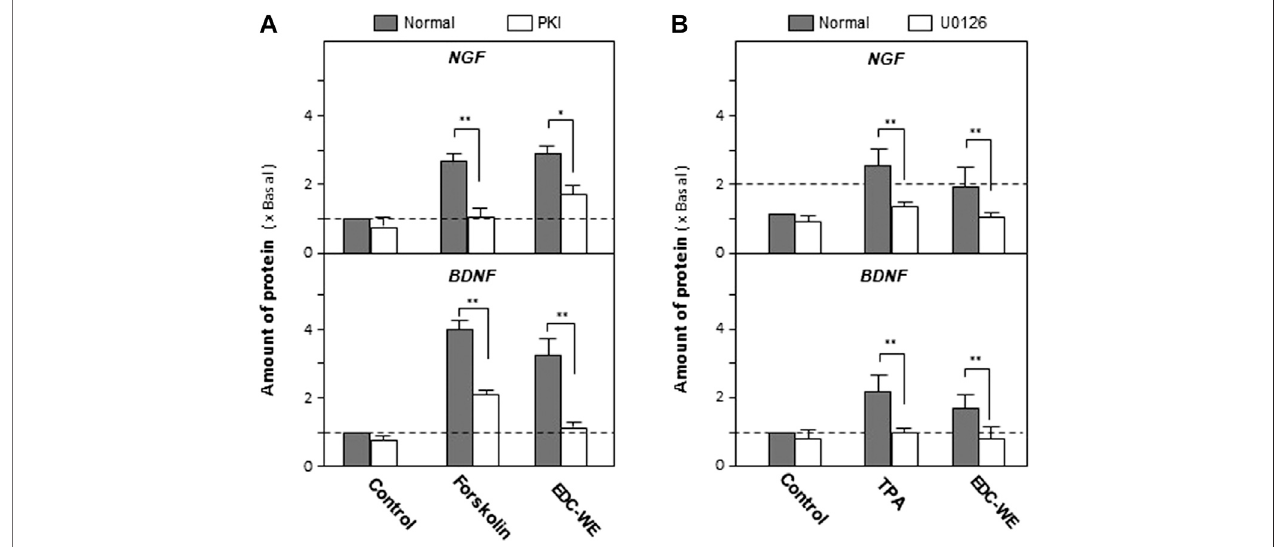
FIGURE 4 | Aqueous extracts of Elaphuri Davidiani Cornu (EDC) increased the expression of nerve growth factor and brain-derived neurotrophic factor in mouse astrocyte primary cultures via the cAMP- and ERK-dependent pathways. (A) : The mouse astrocyte primary cultures were pre-treated with PKI (10 nM) for 3 h and then treated with forskolin (10 μ M) and EDC-WE (3 μ g/ml) for 24 h. The expression of nerve growth factor and brain-derived neurotrophic factor were determined by ELISA. (B) : The mouse astrocyte primary cultures were pre-treated with U0126 (2 μ M) for 3 h and then treated with TPA (100 nM) and EDC-WE (3 μ g/ml) for 24 h. The expression of neurotrophic factors was determined by ELISA. Data are expressed as a fold-change relative to the control group (no-drug treatment) in mean ± SEM, where n (cid:1) 5. * p < 0.05, ** p < 0.01.